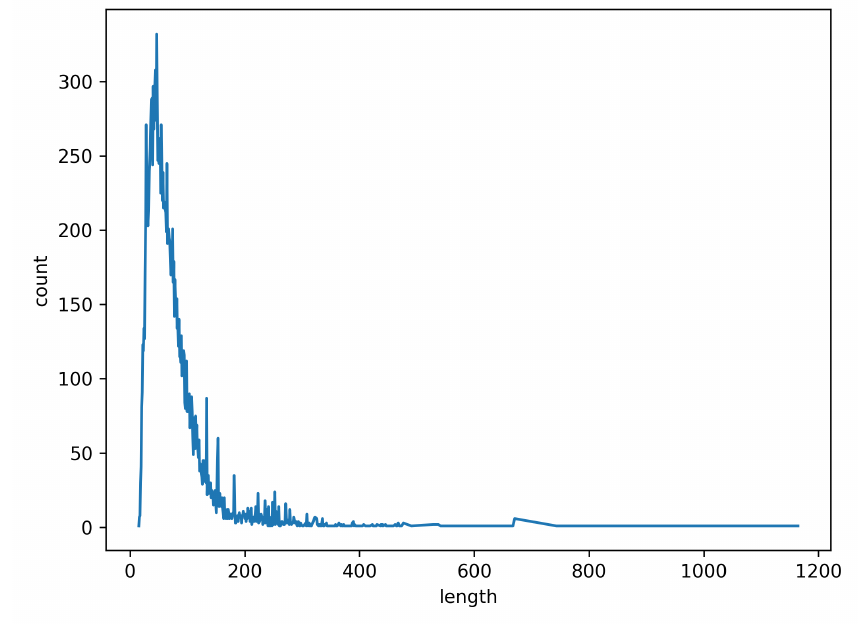
Figure 6. URL length of